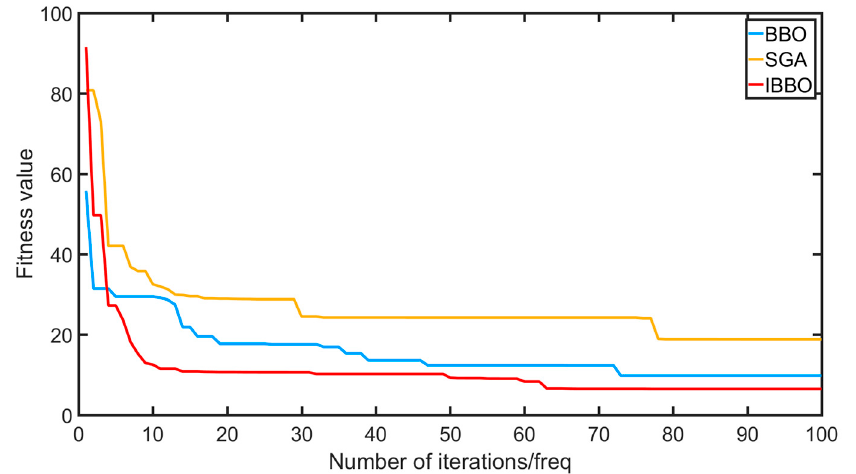
Figure 14. Optimal individual fitness value changes of three algorithms.